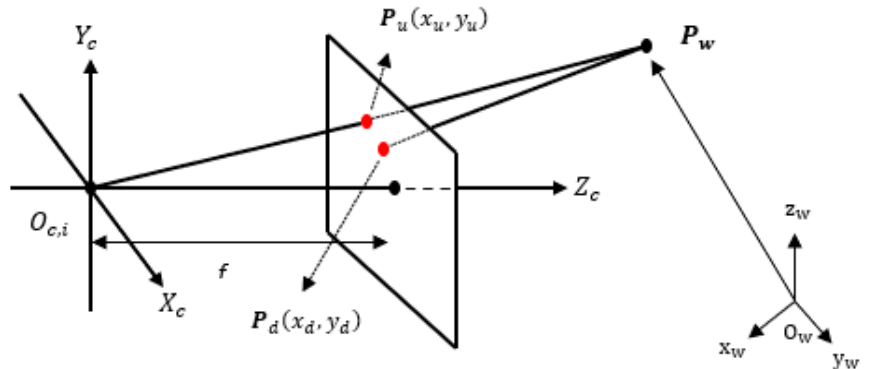
Figure 2. Pinhole camera model C i : {C} represents the camera coordinate system; {W} represents the world coordinate system; O c , i represents the optical center of the i -th camera expressed in the camera coordinate system; O w represents the origin of the world coordinate system; f is the focal length; P d is the distorted point given in pixels; P u represents the corrected point given in pixels; P w is a point in the 3D space represented in world coordinates {W}; Z c = f is the camera image plane.